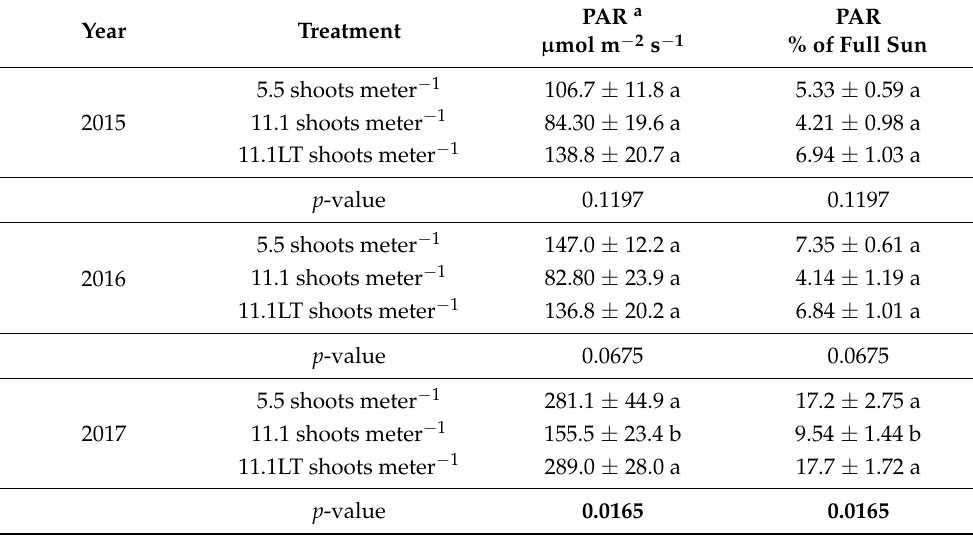
Table 5. One-way analysis of variance (ANOVA) showing average PAR and percentage of full sun values by year and treatment at v é raison during the 2015, 2016, and 2017 growing seasons ( n = 8). Table shows treatment means followed by the standard error of the mean. Different letters within a column indicate significant differences based on an Each pair, Student’s t -test. Significant p -values (<0.05) are displayed in